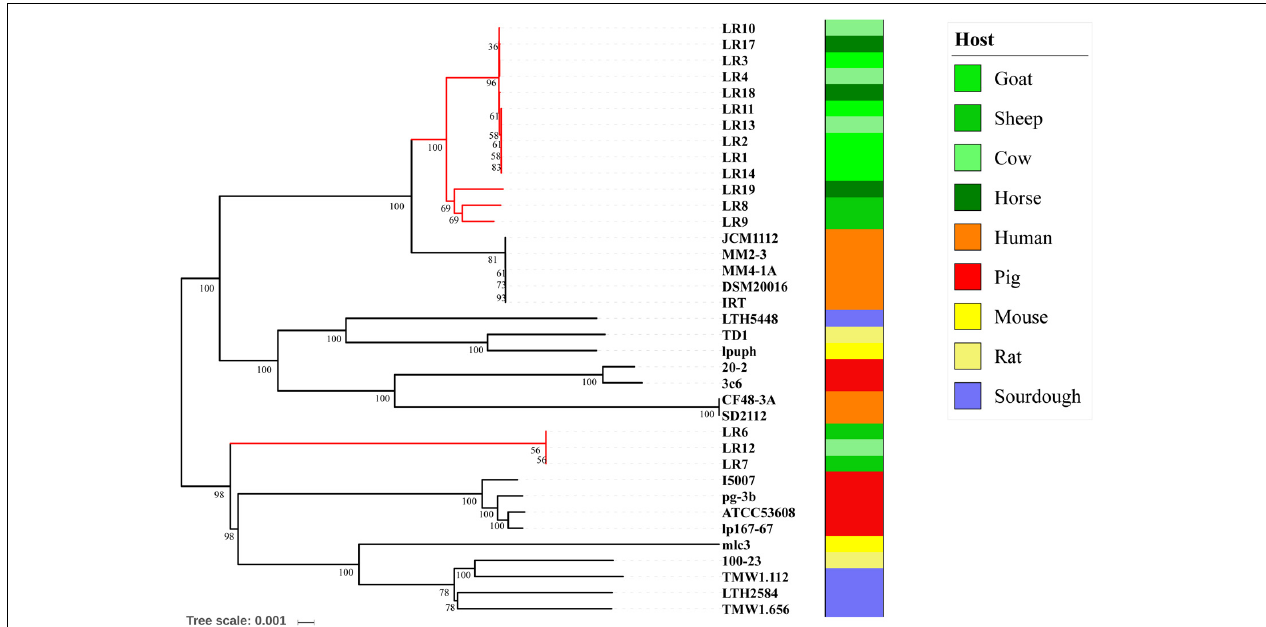
FIGURE 3 | Phylogeny of Lactobacillus reuteri was inferred using a maximum likelihood method.